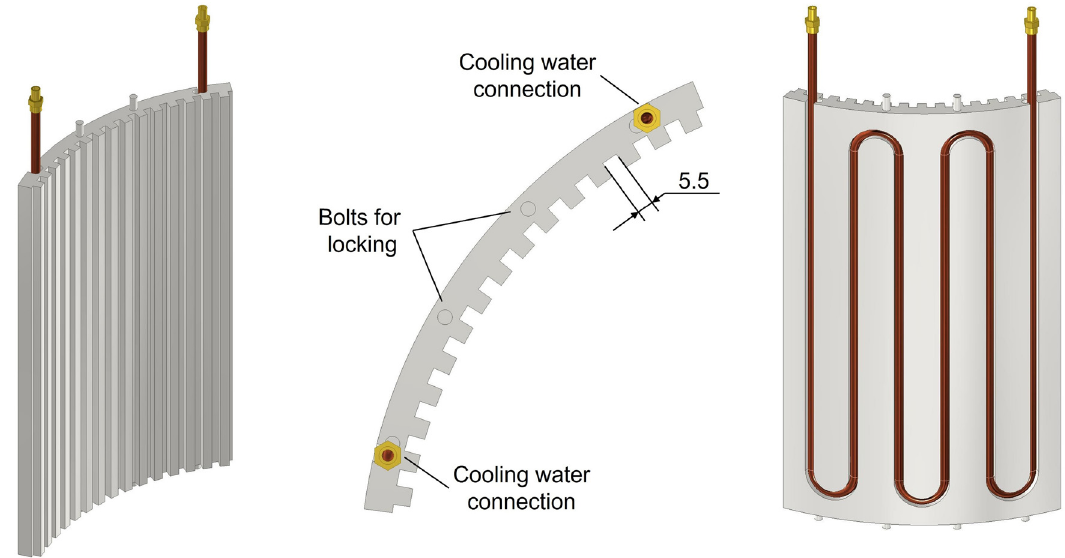
Figure 3: CAD - construction of the cooling pro fi les ( outer cylinder ) ; pro fi les of inner cylinder are similar, but without cooling -